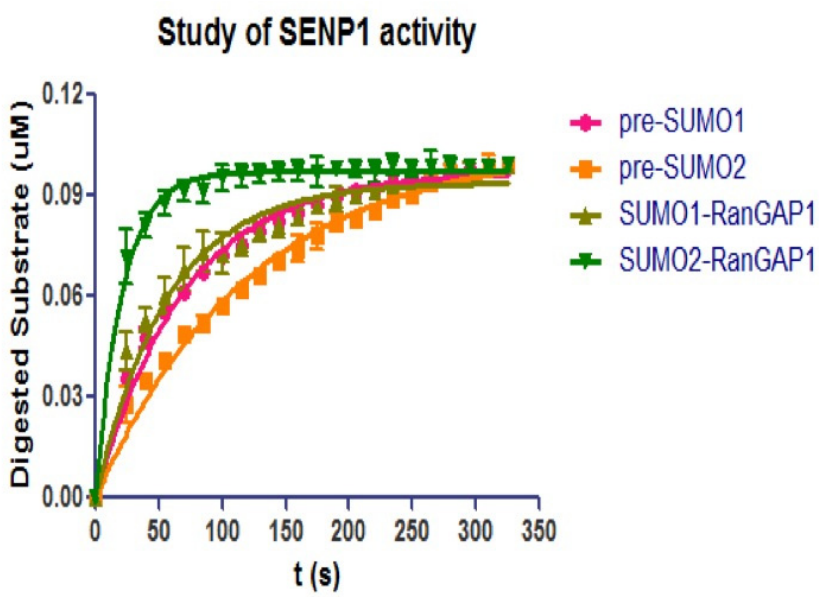
Figure 6. QFRET analysis to compare SENP1C’s endo- and iso-peptidase activities. 0.1 µ M Substrate CyPet-(pre-SUMO1)-YPet, CyPet-(pre-SUMO2)-YPet, CyPet-SUMO1-RanGAP1C-YPet-GST, and CyPet-SUMO2-RanGAP1C-YPet-GST were incubated with 0.5 nM SENP1C in low salt Tris buffer at 37 ◦ C. Reactions were monitored as the fluorescent emission at 475 nm and 530 nm (under the excitation of 414 nm) for every 10 s in the first 5 min. The digested substrate concentrations were calculated based on the developed qFRET analysis. Data were plotted in GraphPad Prism V and nonlinear regression. Table 1. The initial velocity ( v 0 ) of pre-SUMO1/2 maturation and SUMO1/2- RanGAP1C deconju- gation by SENP1C derived by qFRET analysis (substrate concentration was 0.1 µM).